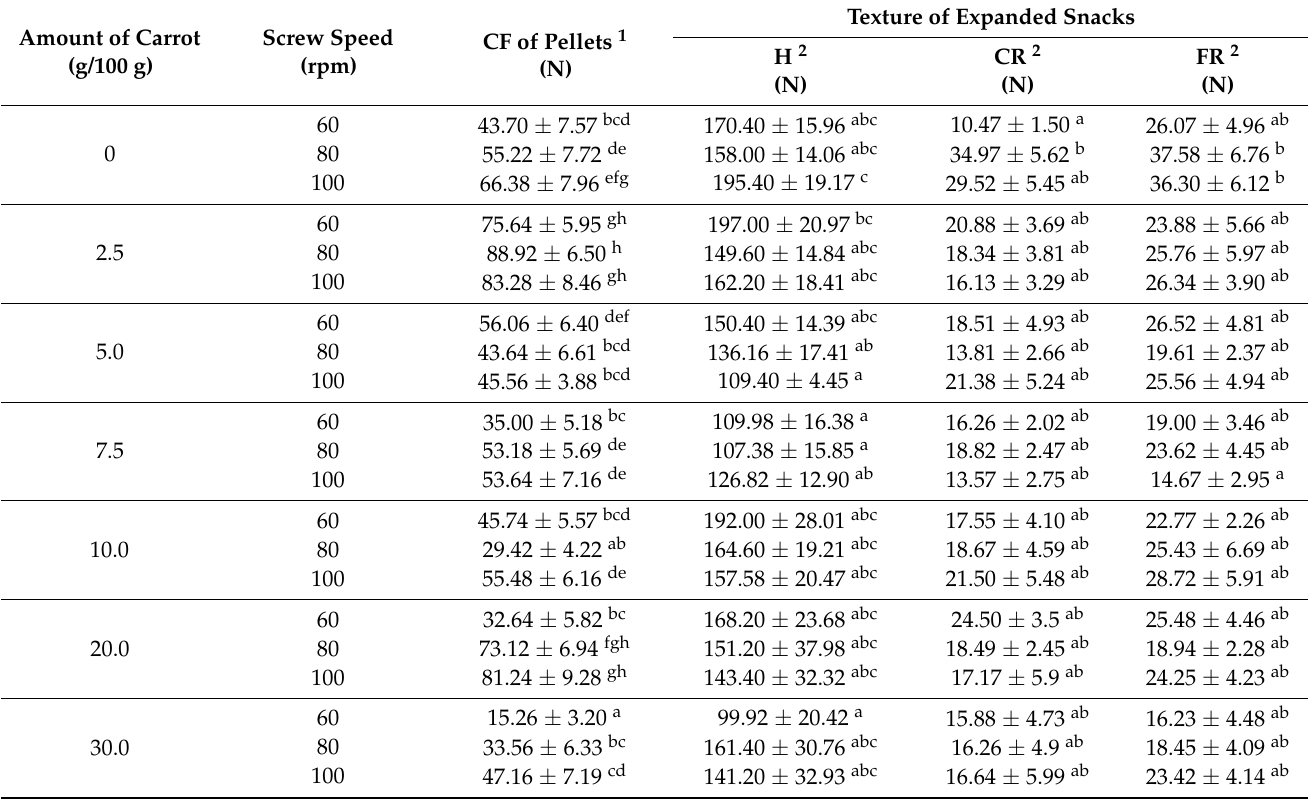
Table 4. Cutting force of pellets and the texture profile of microwave-expanded snacks with the addition of fresh carrot pulp. Amount of